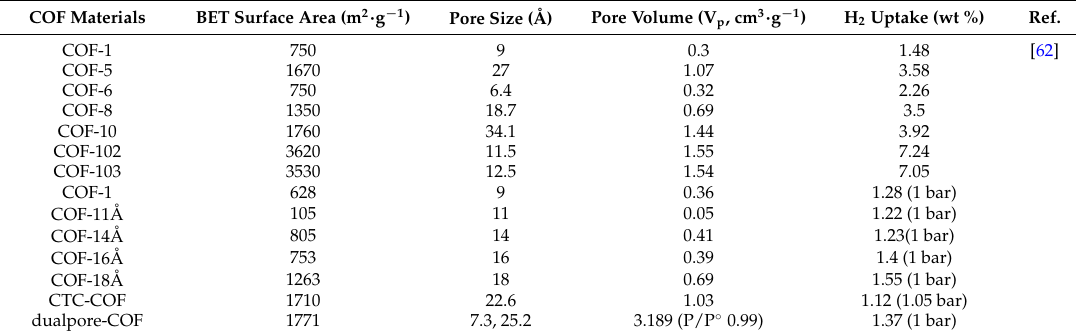
Table 1. BET surface area, porosity parameters and H 2 capture of selected